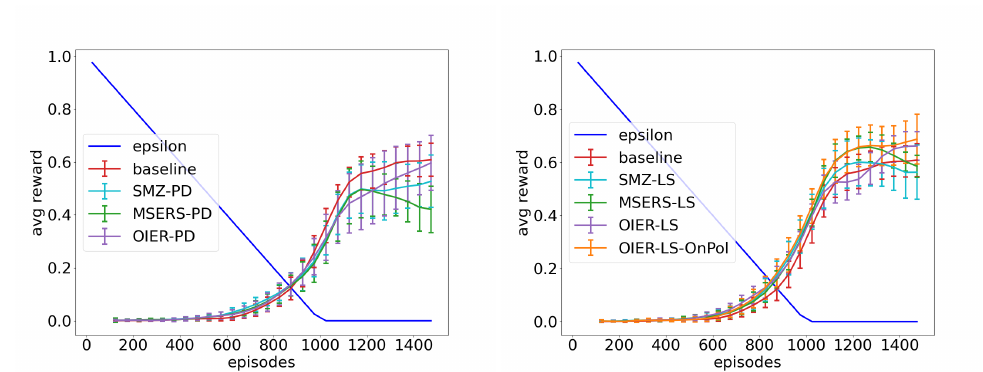
Figure A12. The results for state encoding: LKE and IER mode: LS. t expl = 750. t expl =